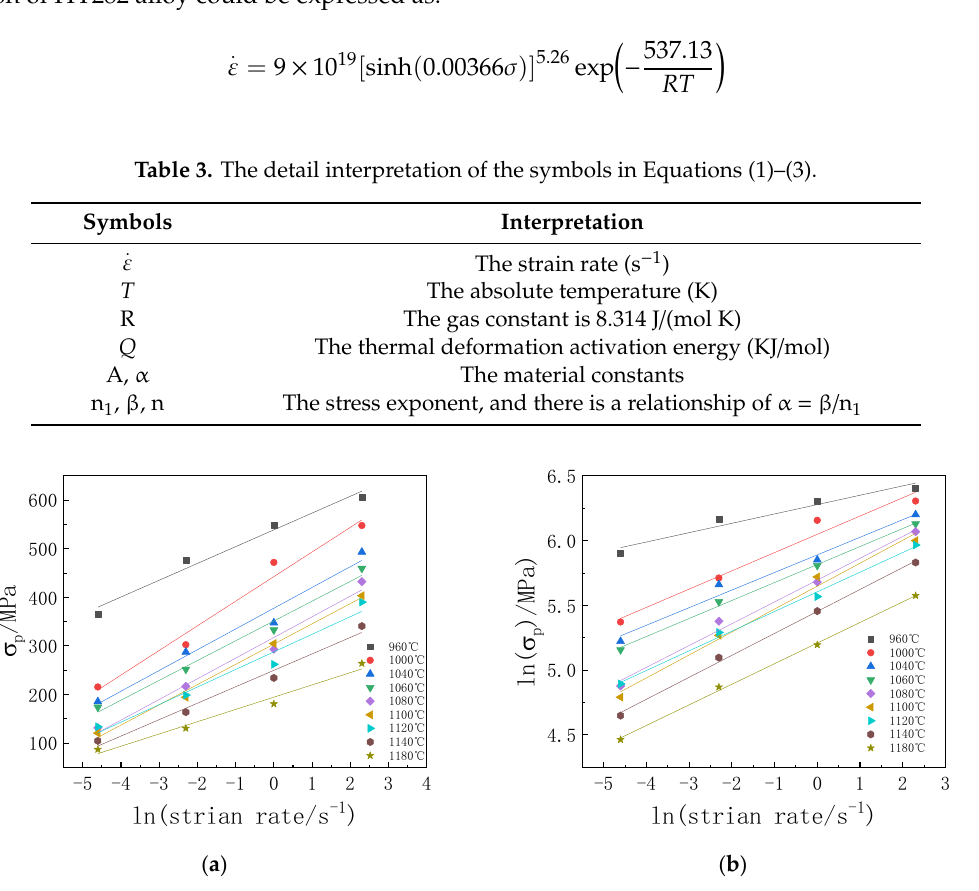
Figure 3. Variations of peak stress of HY282 alloy with deformation temperature and strain rate: ( a ) ln(strain rate)- σ p ; ( b ) ln(strain rate)-ln( σ p ).